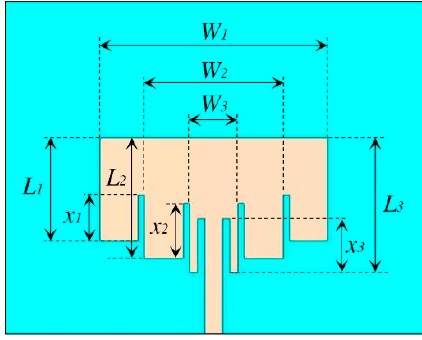
Table 2. MPA3 geometrical parameters.